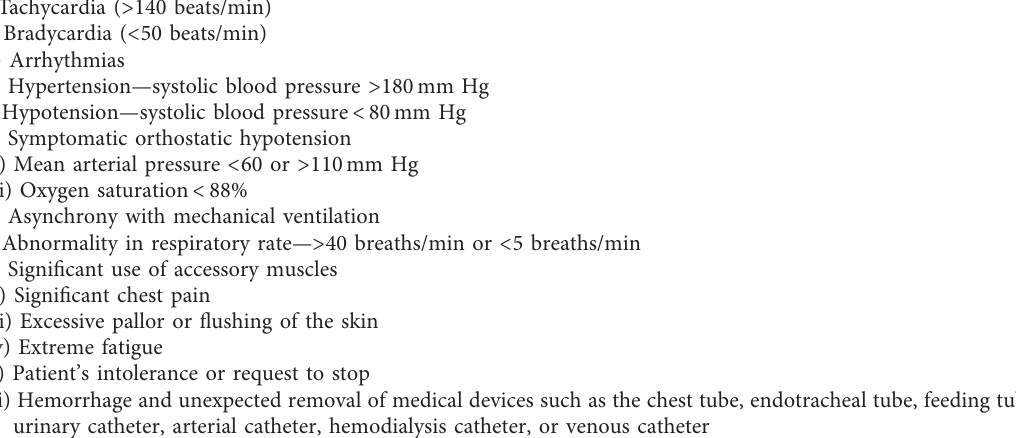
Table 8: Criteria for termination of mobilization.